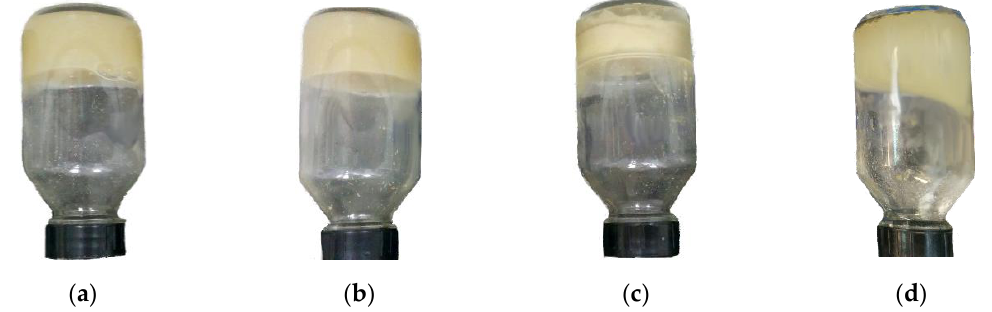
Figure 10. Acrylamide-based polymers, PEI, and bentonite hydrogels prepared at 85 °C in 1.0 wt % brine of ( a ) NaCl, ( b ) KCl, ( c ) MgCl 2 , and ( d ) CaCl 2 .